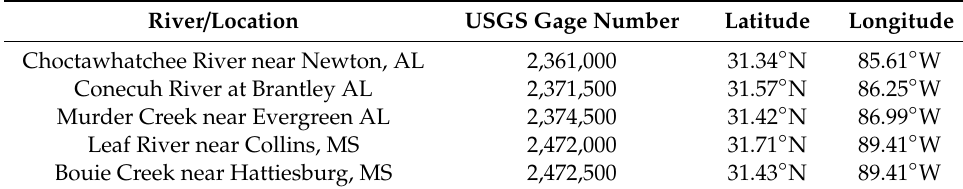
Table 1. The five unimpaired streamflow gages used in this study. River / Location USGS Gage Number